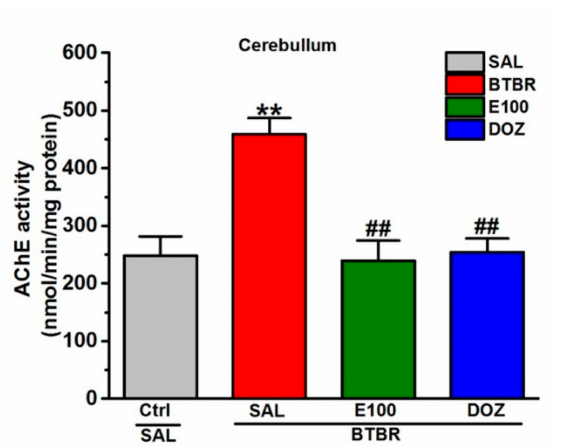
Figure 5. E100 reduced the enhanced acetylcholine esterase activity levels in BTBR mice cerebellum tissues. E100 (5 mg / kg, i.p.) provided inhibitory e ff ects on AChE activity in the cerebellum of BTBR mice. Analysis revealed quantitively a significant increase ( ** p < 0.01) in the AChE activity in cerebellum of BTBR mice compared to the control mice. E100 (5 mg / kg, i.p.) or DOZ (1 mg / kg, i.p.) subchronic (21 days) treatment significantly reduced ( ## p < 0.01) this activity in BTBR mice compared to the saline-treated BTBR mice. Values are expressed as the percent mean ± SEM (n =